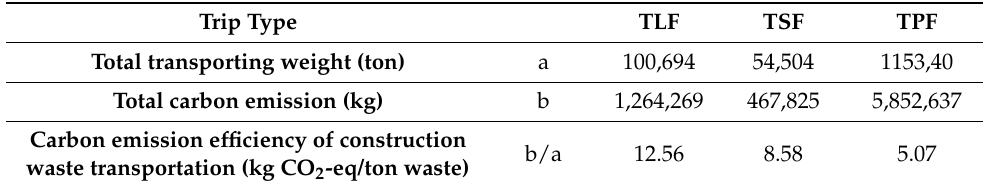
Table 7. Carbon emission efficiency of construction waste transportation.